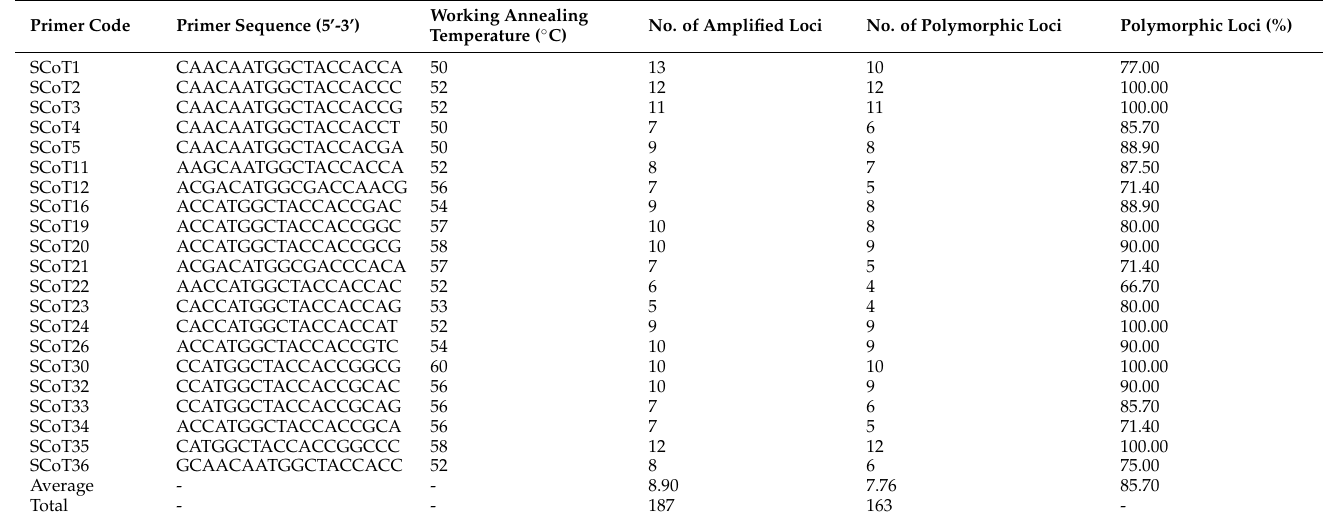
Table 1. Sequences and polymorphism information of the 21 SCoT